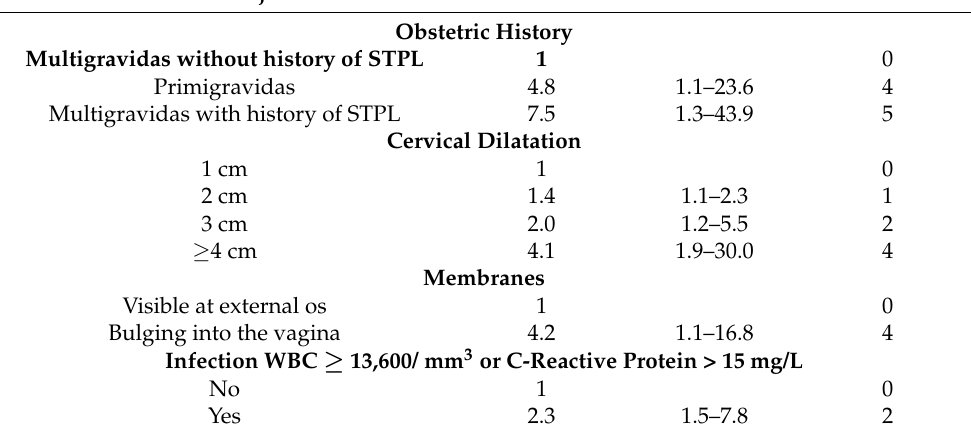
Table 3. Factors associated with early preterm delivery in the multiple logistic regression model and number of points contributed to the score by each factor. Reprinted with permission from ref. [64]. Copyright 2012